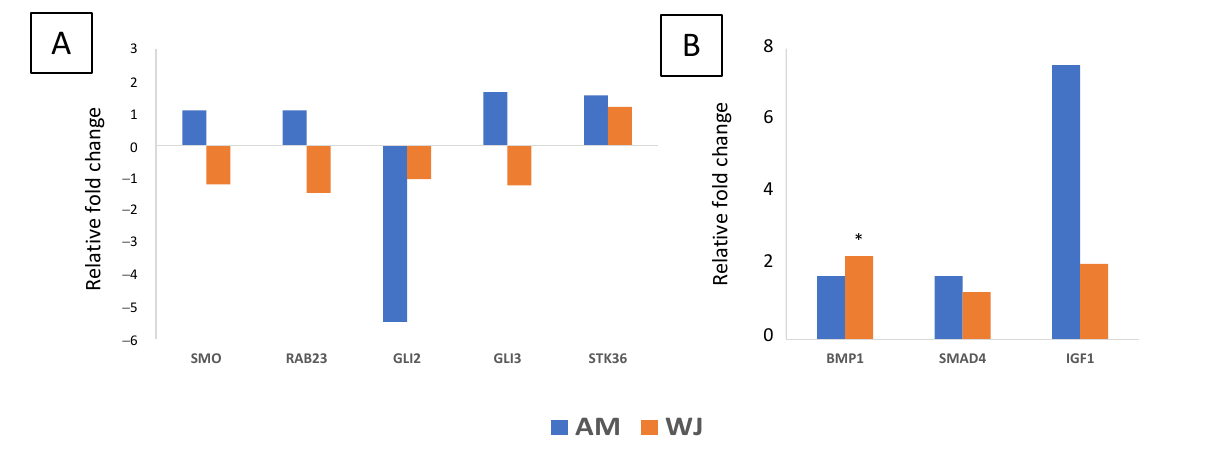
Figure 8. Differential expression of genes associated with ( A ) Hedgehog and ( B ) other signalling pathways in AM- and WJ-MSCs during osteogenesis. Asterisks (*) represent statistical significance p < 0.05.